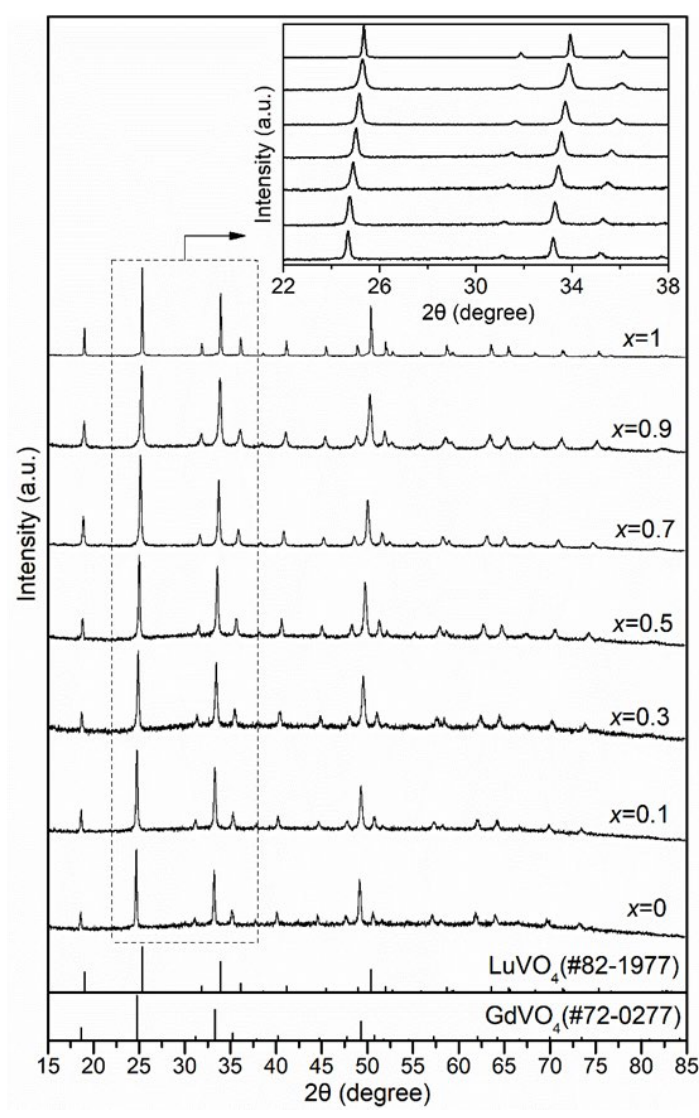
Figure 1. X-ray diffraction patterns of tetragonal Lu x Gd 1 − x VO 4 with standard patterns of GdVO 4 and LuVO 4 shown at the bottom (vertical bar). The inset is an enlargement of the 2θ region between 22° and 38°.